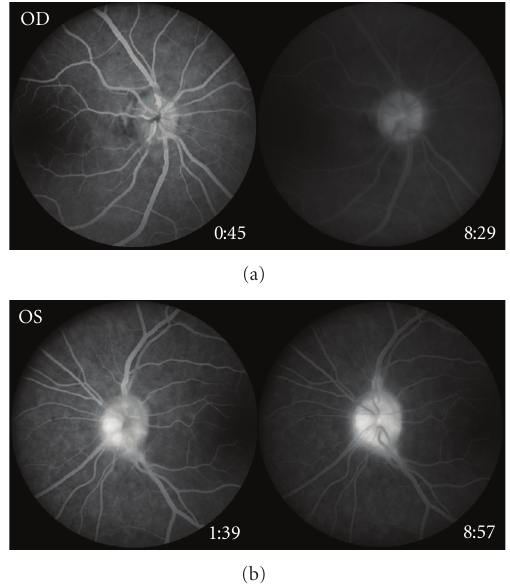
Figure 3: (a) Fluorescein angiogram of the right optic disc dem- onstrating focal leakage. (b) Fluorescein angiogram of the left optic disc demonstrating focal